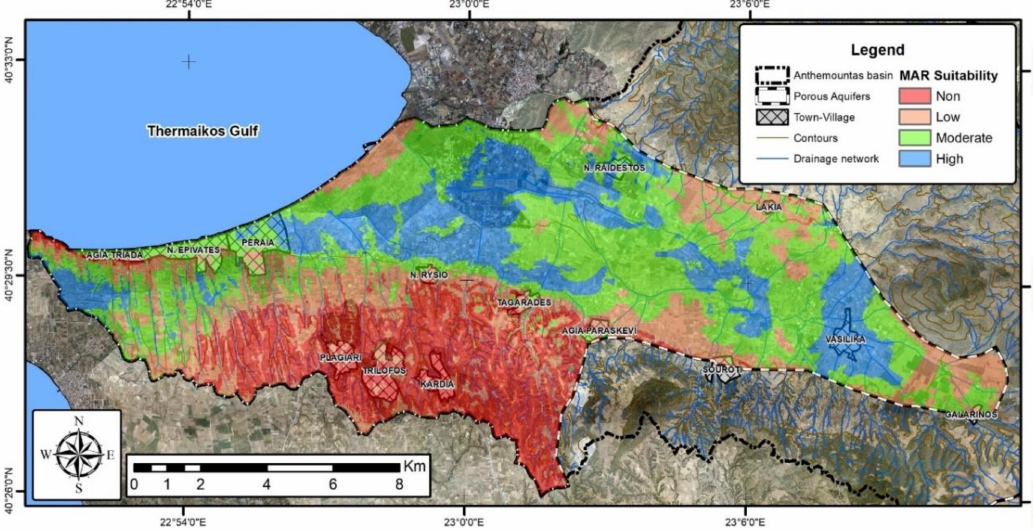
Figure 4. Map of MAR application suitability in the coastal aquifer of Anthemountas basin.